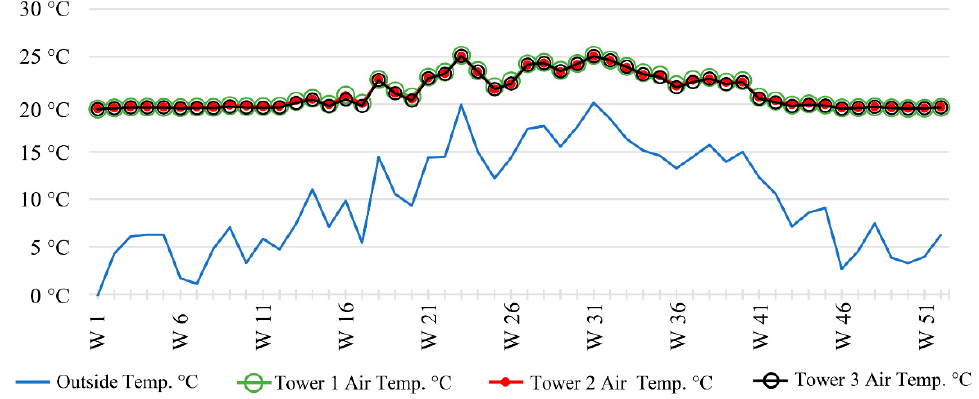
Figure 18. Average air temperatures of the optimised Europoint complex.